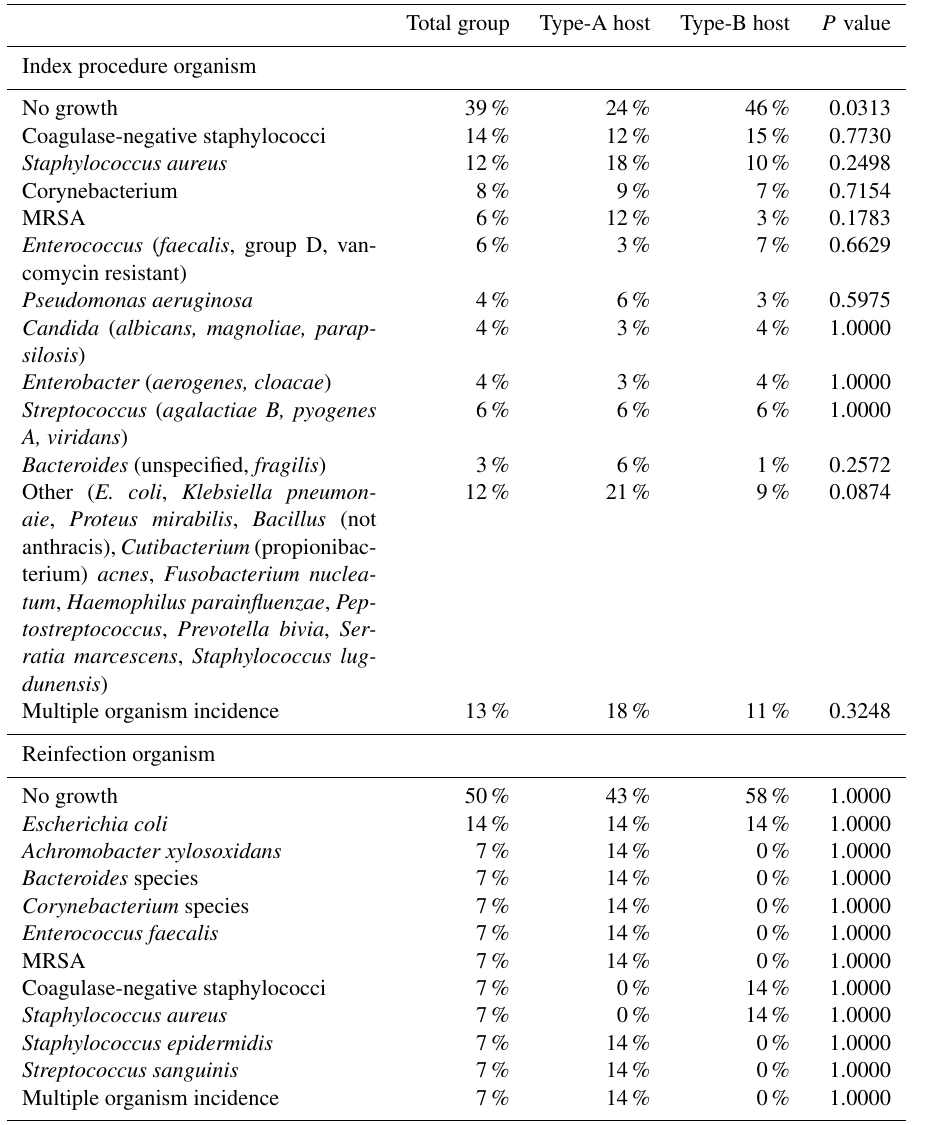
Table 2. Organism growth with incidence comparison between host